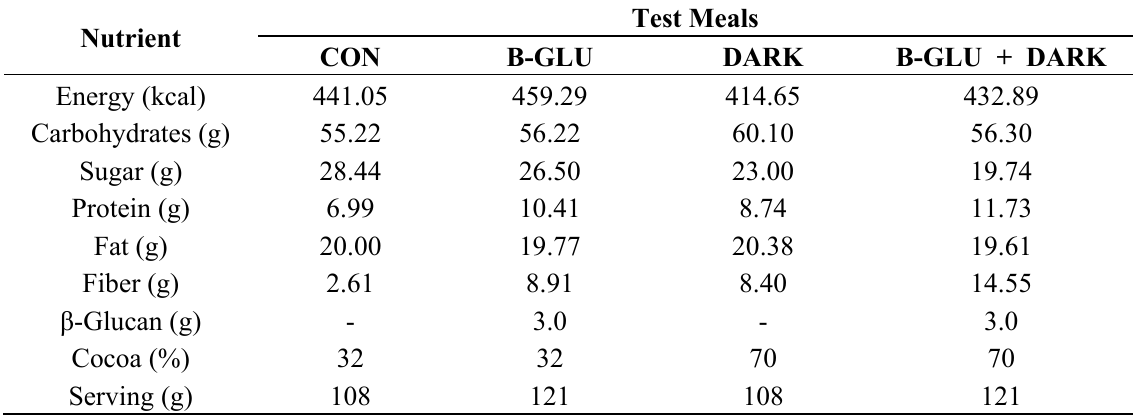
Table 1. Nutritional composition and serving weight of test